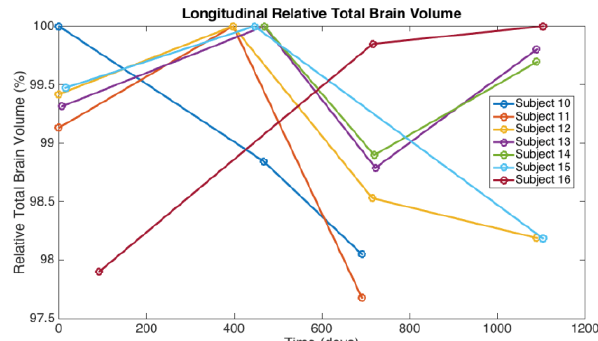
Figure 2. The longitudinal relative total brain volume of seven women soccer athletes who were assessed over a four year period.